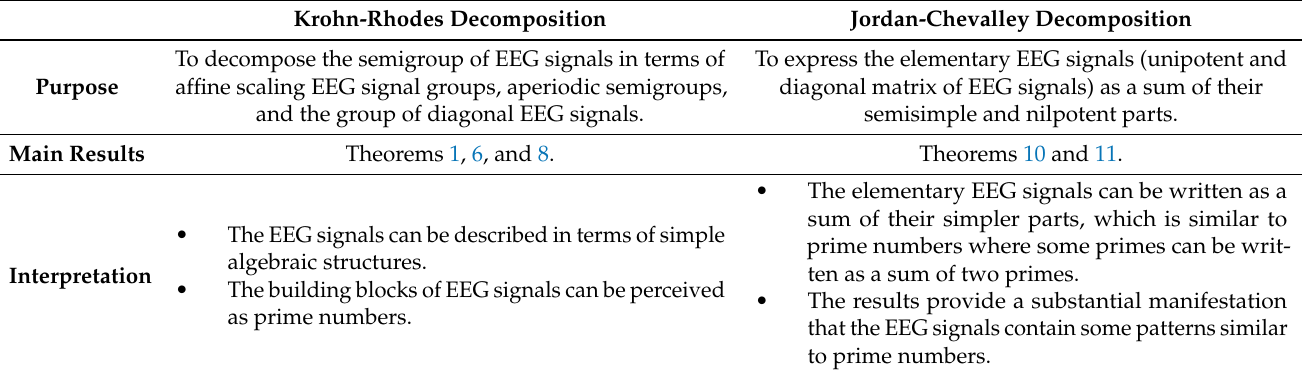
Table 9. Summary of decomposition techniques executed on the EEG signals and their significant